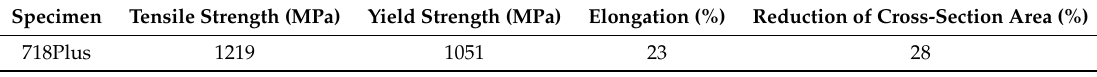
Figure 3. Microstructure of as-received dwell-fatigue-crack growth rate (DFCGR) specimen. ( a , b ) Figure3. Microstructureofas-receiveddwell-fatigue-crackgrowthrate(DFCGR)specimen. ( a , b )optical optical microscopy (OM) observation (grain size ~11 µm); ( c ) field-emission SEM (FESEM) observation. Table 2. Mechanical properties at 704 ◦ C of experimental Table 2. Mechanical properties at 704 °C of experimental superalloy.